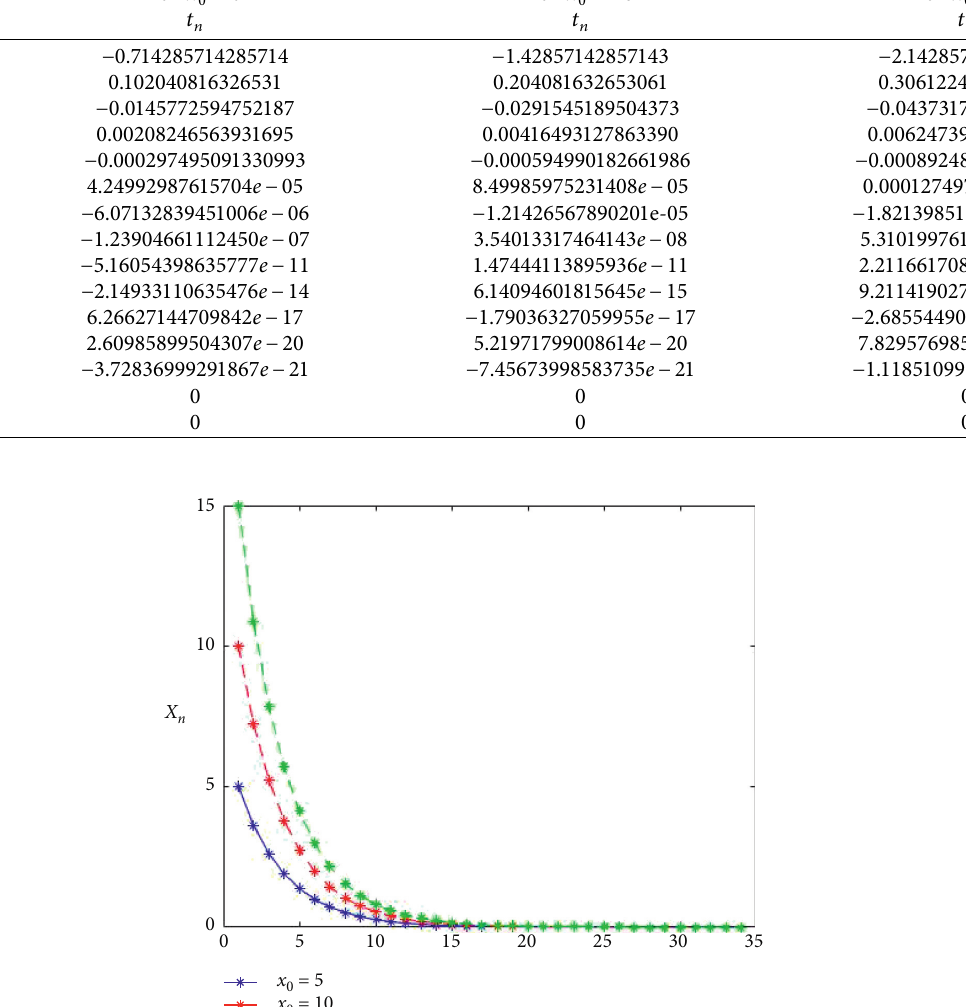
x � 5, x � 10, and x 0 0